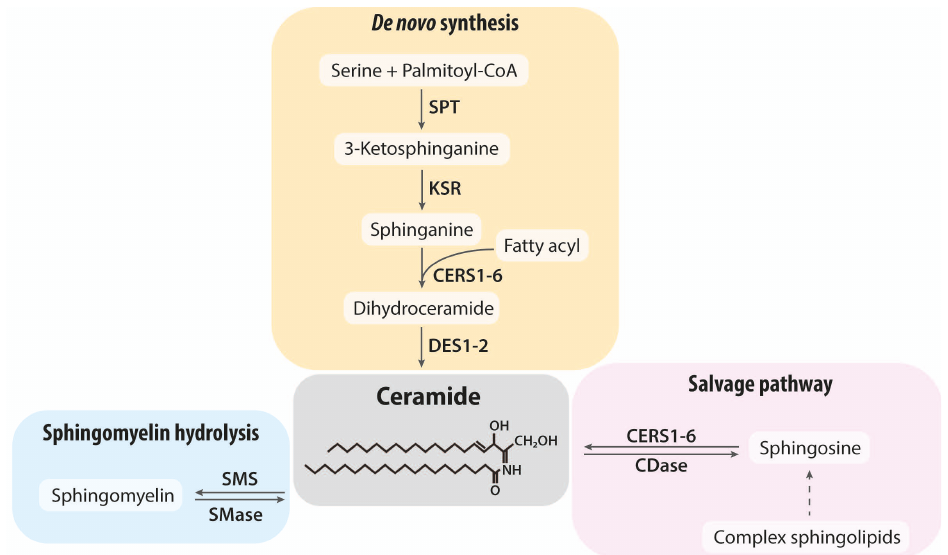
Figure 1. Schematic representation of sphingolipid metabolic pathways that alter ceramide levels. Ceramide can be generated through (1) the de novo synthesis pathway; or (2) sphingomyelin hy- drolysis pathway. Complex sphingolipids can also be degraded back to ceramide, which is called (3) the salvage pathway. Abbreviations: SPT, serine palmitoyltransferase; KSR, 3-ketosphinganine reductase; CERS, ceramide synthase; DES, dihydroceramide desaturase; CDase, ceramidase; SMS, sphingomyelin synthase, SMase,